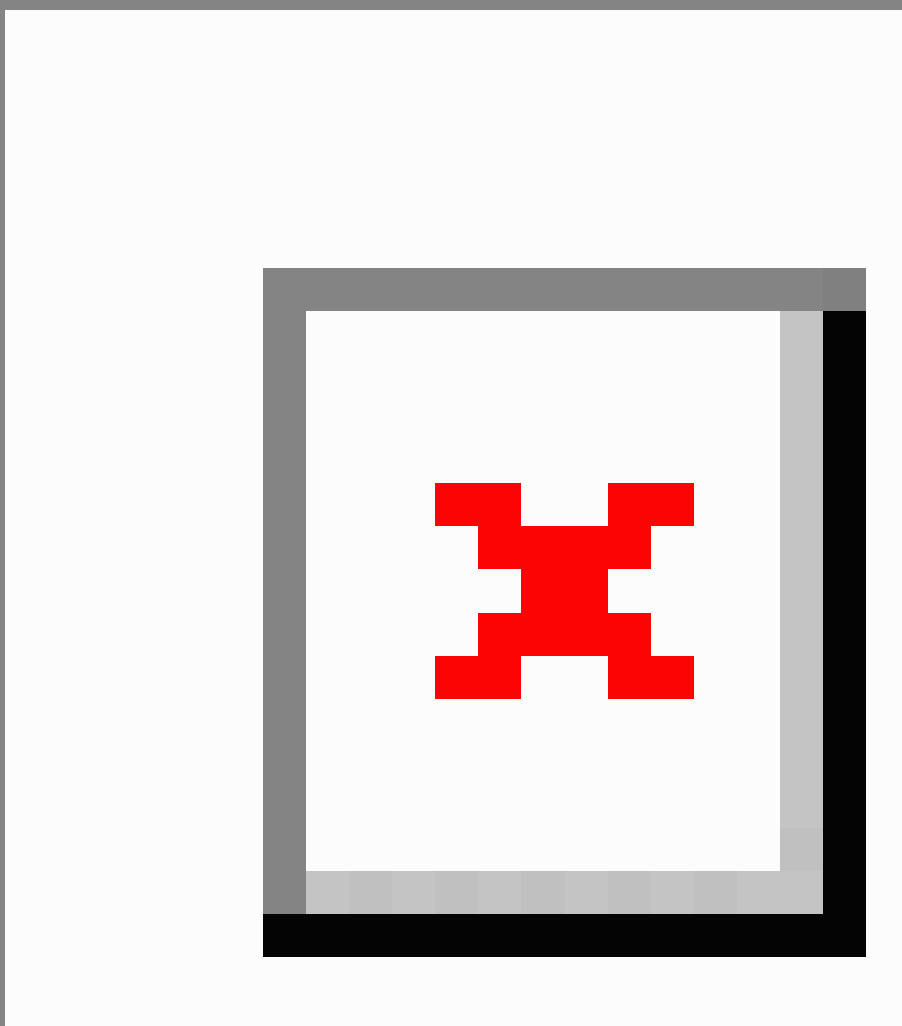
Figure 2. Two-word text cloud created in Many